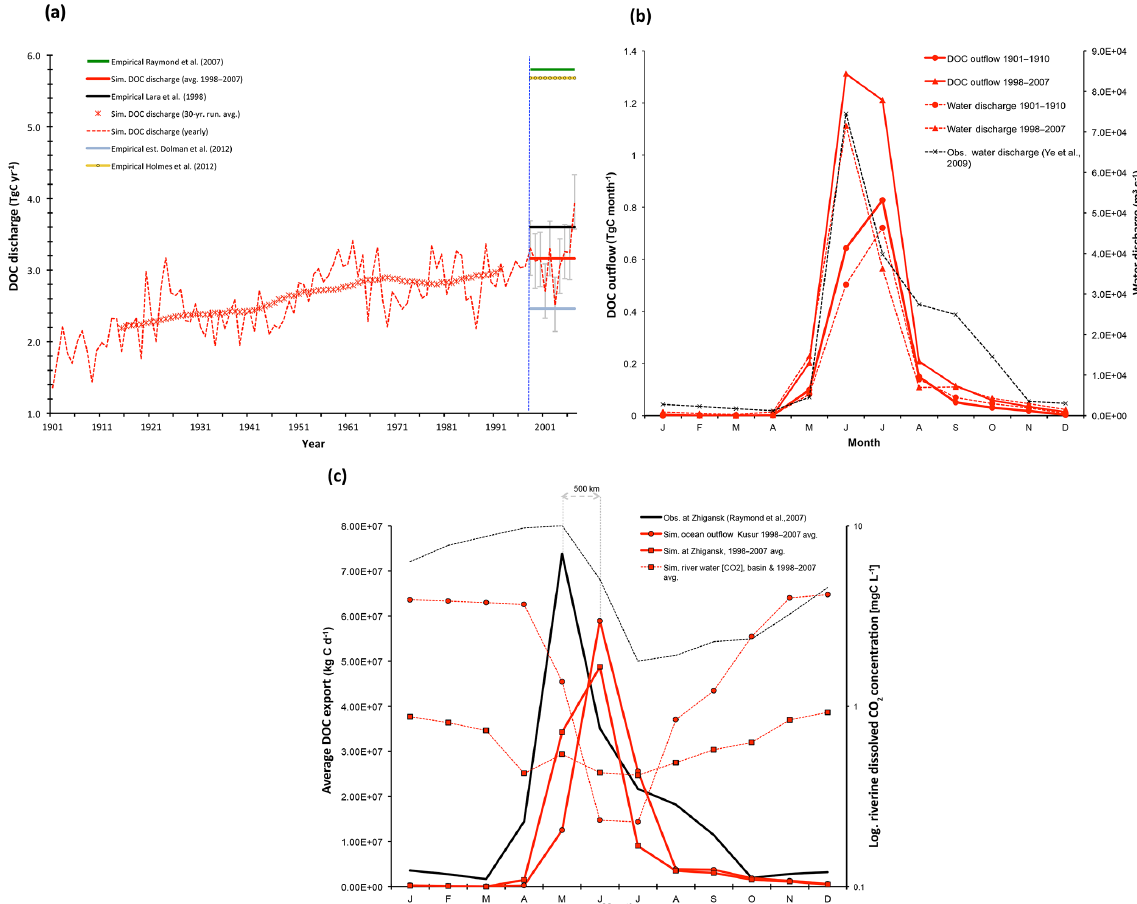
Figure 4. (a) Yearly DOC discharged from the Lena River into the Laptev Sea is shown here (tCyr − 1 ), over the entire simulation period (dashed red line), with the smoothed 30-year running mean shown by the asterisk symbols. Observation-based estimates for DOC discharge from Lara et al. (1998), Raymond et al. (2007), Dolman et al. (2012), and Holmes et al. (2012) are shown by the horizontal black, green triangle, blue diamond, and yellow circle line colours and symbols, respectively, and are to be compared against the simulated mean over the last decade of simulation (1998–2007, horizontal red line), with error bars added in grey displaying the standard deviation of simulated values over that period. (b) Average monthly DOC discharge (solid red, tCmonth − 1 ) and water discharge (dashed red, m 3 s − 1 ) to the Laptev Sea over the period averaged for 1901–1910 (circles) and 1997–2007 (squares) are compared, with modern maxima closely tracking observed values. Observed water discharge over 1936–2000 from R-ArcticNet v.4 (Lammers et al., 2001) and published in Ye et al. (2009) are shown by the dashed black line. (c) Observed (black) and simulated (red) seasonal DOC fluxes (solid lines) and CO 2 discharge concentrations (dashed lines). Observed DOC discharge as published in Raymond et al. (2007) from 2004–2005 observations at Zhigansk, a site ∼ 500km upstream of the Lena delta. This is plotted against simulated discharge for (i) the Lena delta at Kusur (red circles) and (ii) the approximate grid pixel corresponding to the Zhigansk site (red squares) averaged over 1998–2008. Observed CO 2 discharge from a downstream site (Cauwet and Sidorov, 1996; dashed black), and simulated from the outflow site (dashed circle), and the basin average (dashed square) are shown on the log-scale right-hand axis for